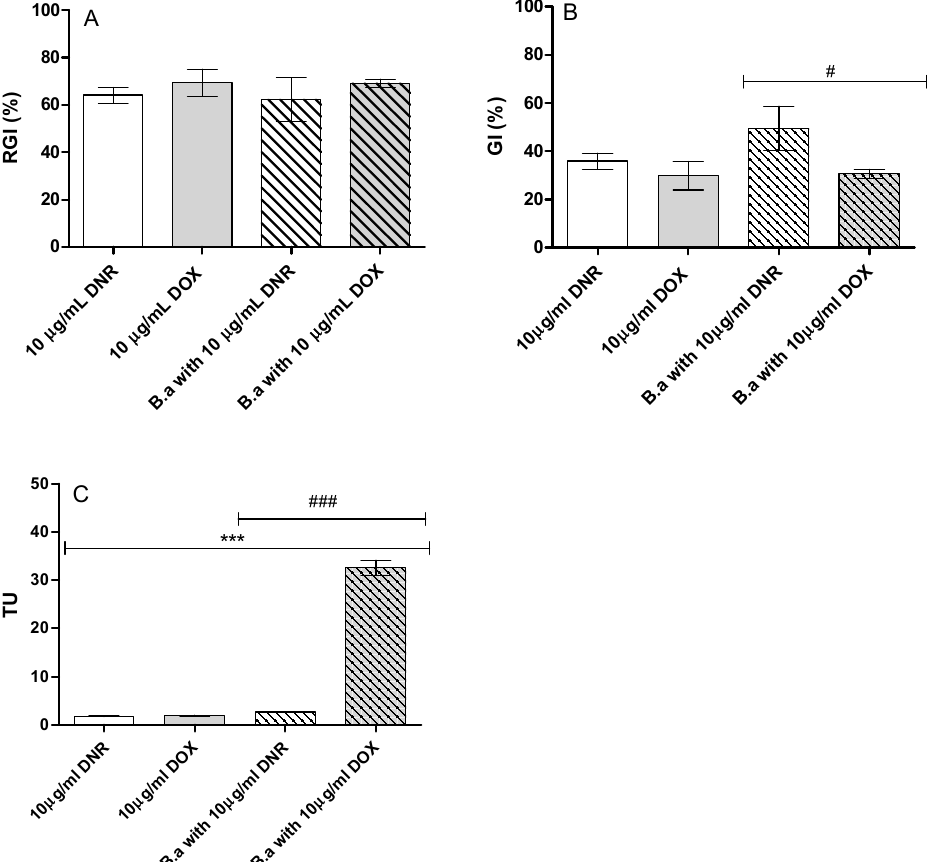
Figure 3. Phyto- ( A , B ) and biotoxicity ( C ) initial solutions of DNR and DOX (10 µg/mL) and decolorized post-culture liquids of B. adusta CCBAS 930 (RGI—root growth inhibition, GI—germination index, TU- Toxicity Units: *** p < 0.001 versus the control anthracycline antibiotics: DNR and DOX, ### p < 0.001; # p < 0.05 between post-cultured fluids B. adusta CCBAS 930.